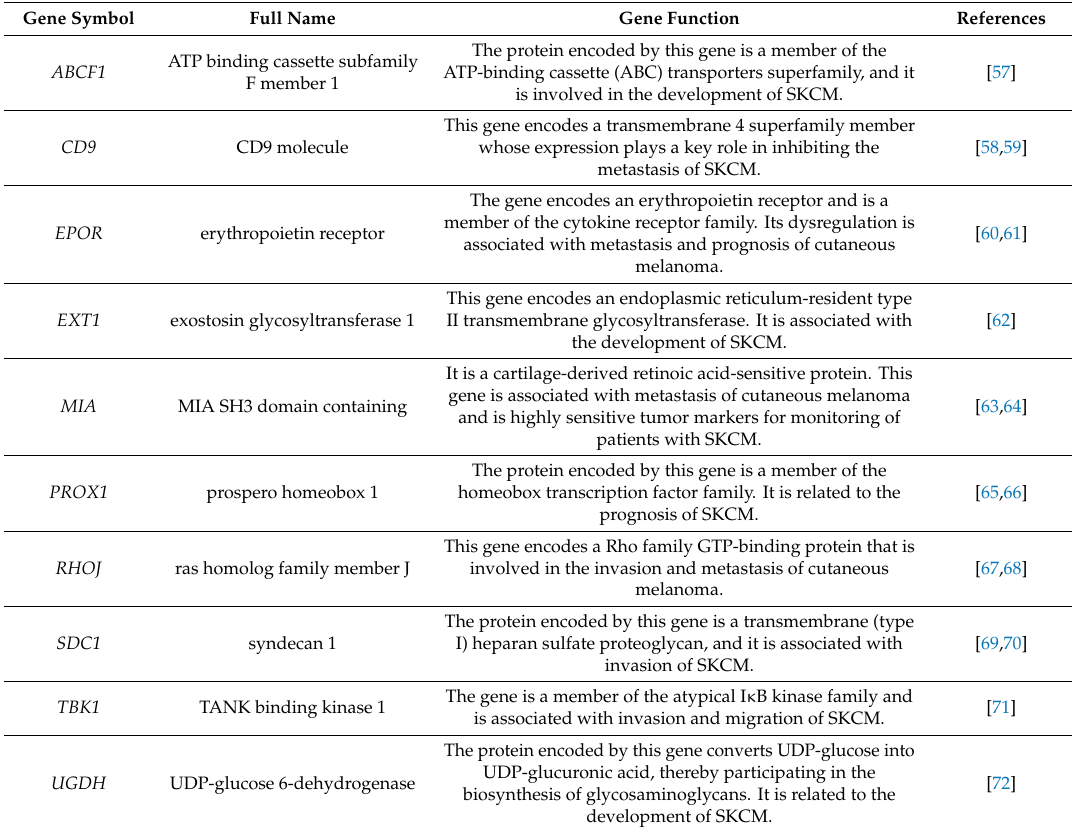
Figure 8. Core module network of skin cutaneous melanoma. The red solid circle indicates the local network topology diagram associated with genes APPL1 , BCL2L2 , TRIM3 , and UEVLD . Table 2. Known genes associated with skin cutaneous melanoma development, metastasis, and prognosis in the core module network.